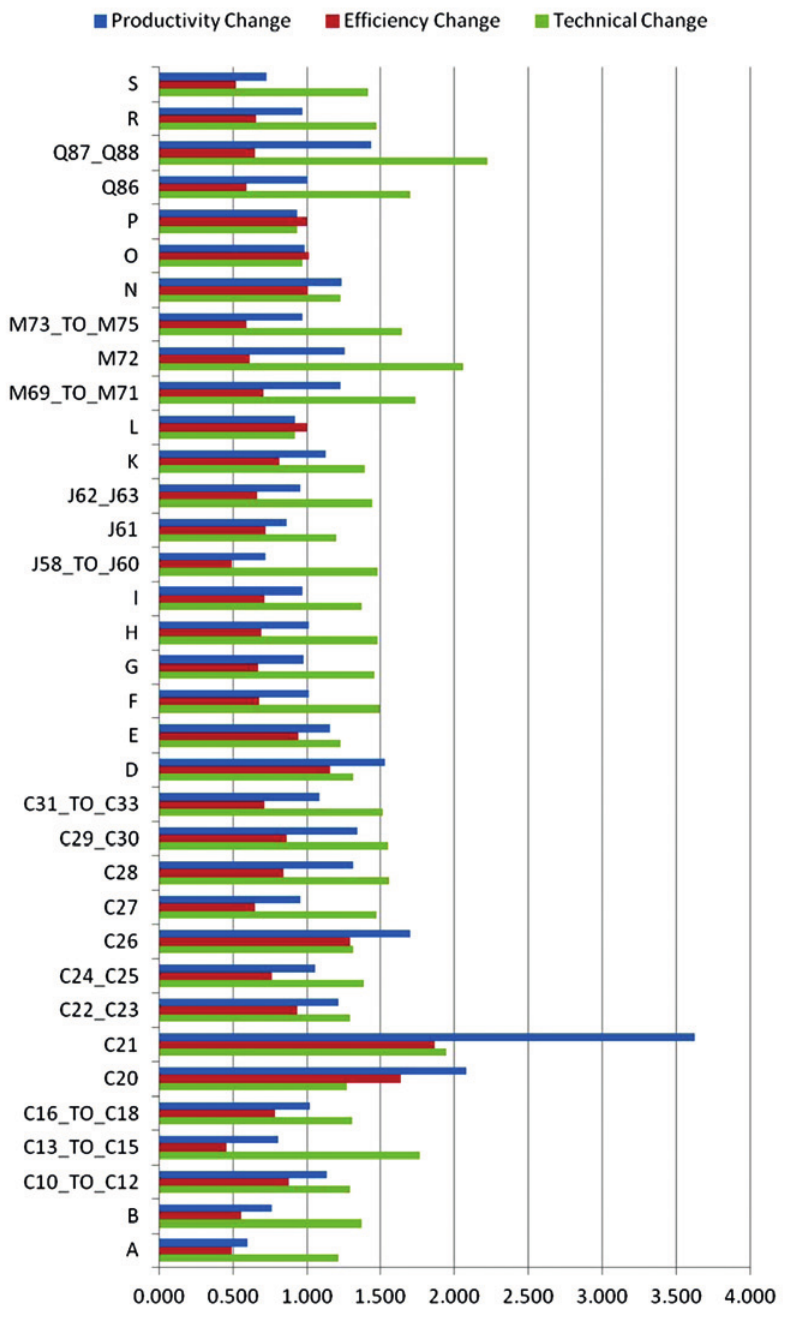
Fig. 3. Malmquist productivity index across economic sectors, 2010 compared to 2000 Note: see Table A1 in Appendix A for